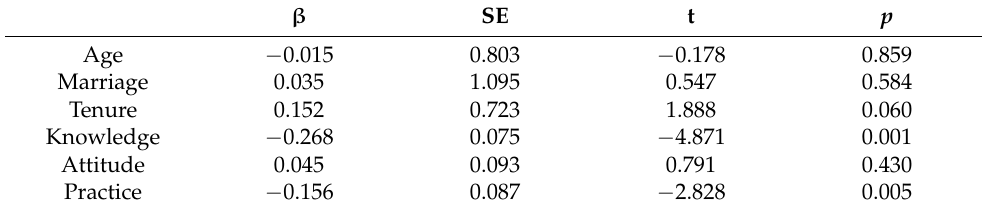
Table 4. Factors affecting job